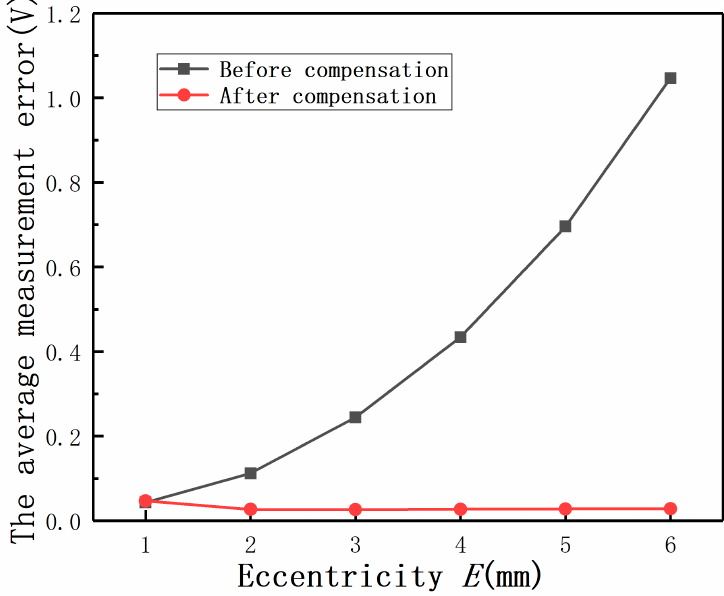
Figure 26. The average measurement errors before and after compensation.